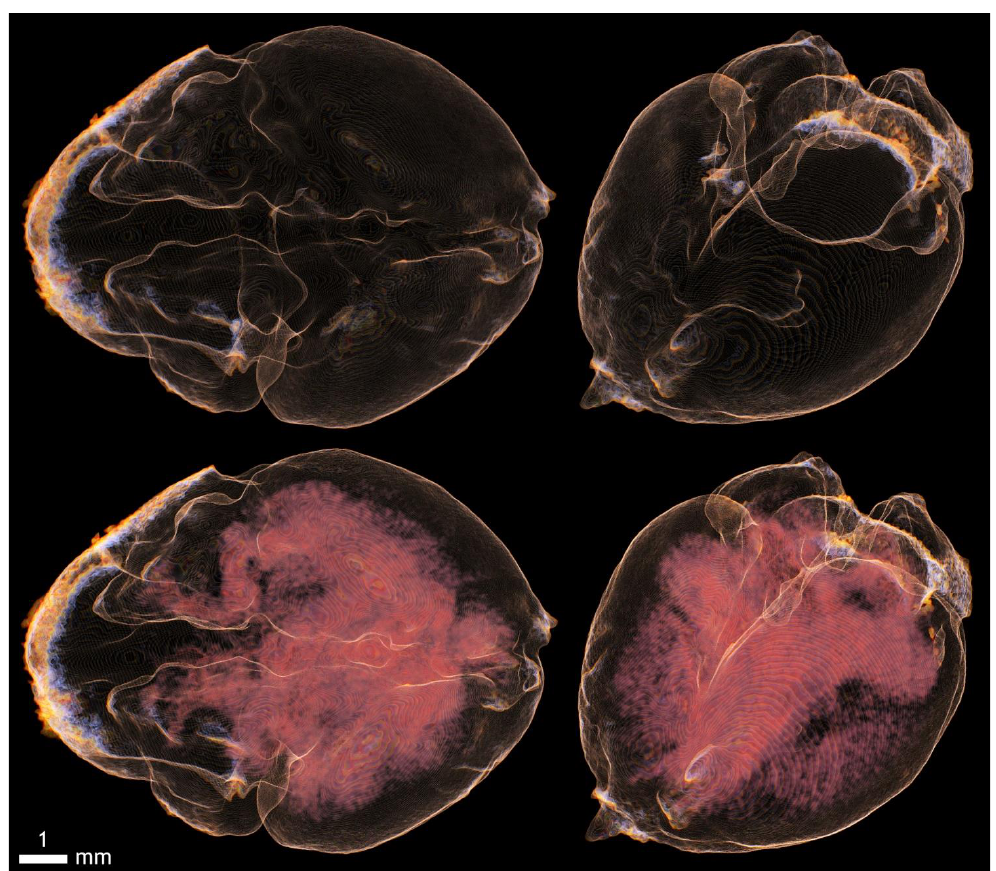
Figure A14. Imaging of the cerebral lobes and internal ventricular system with KI and 20% ethanol.